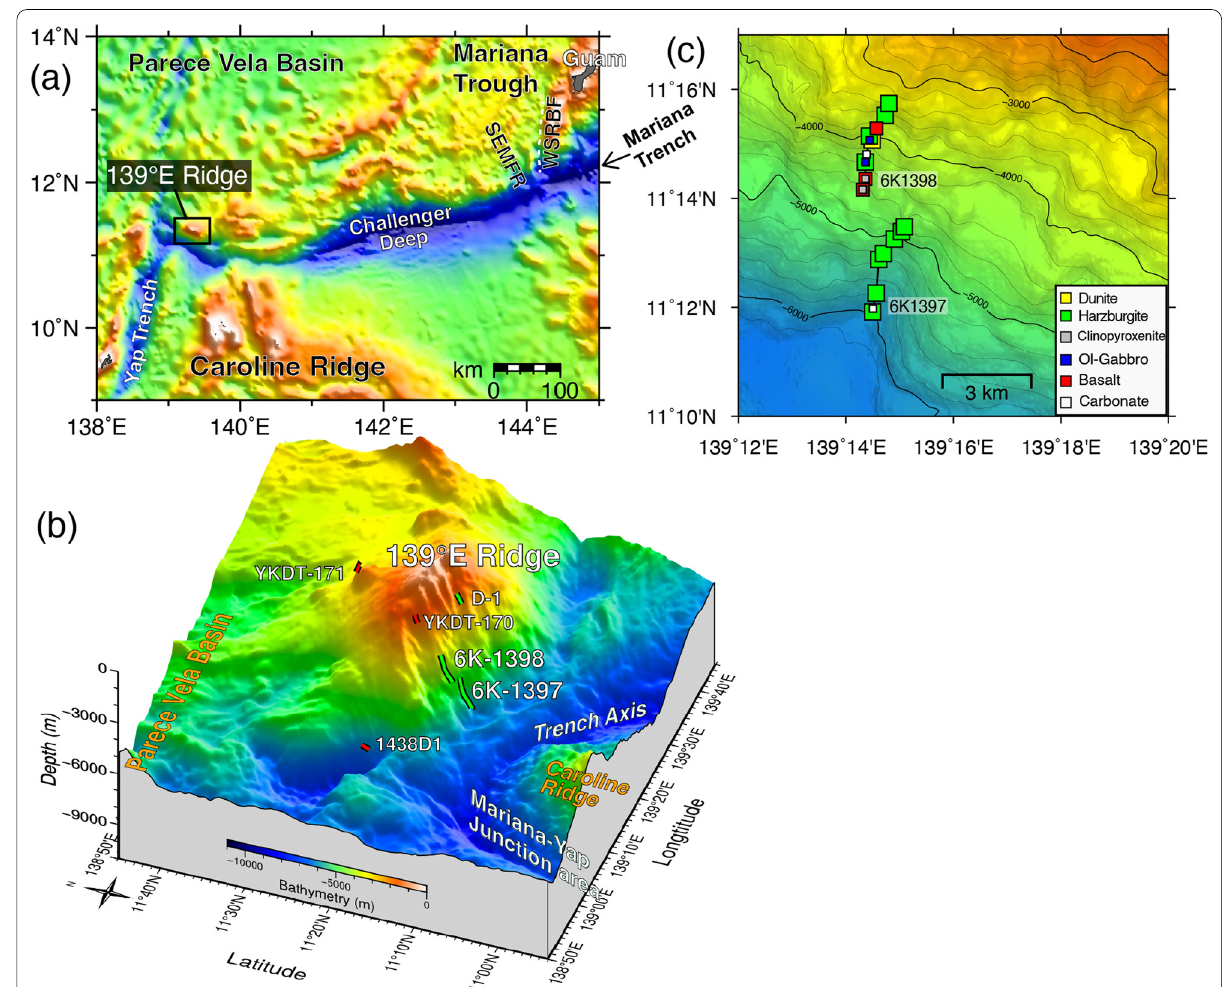
Fig. 1 a Bathymetric map of the region around the southern Mariana Trench. SEMFR: Southeast Mariana Forearc Ridge; WSRBF: West Santa Rosa Bank Fault. b Three‑dimensional perspective view of the 139°E Ridge. Shinkai 6500 dive tracks (6K‑1397 and 6K‑1398) are shown by green lines. Deep‑tow camera dive tracks (YKDT‑170 and YKDT‑171) are shown by red lines. D‑1 is the dredge line reported by Hawkins and Batiza (1977). 1438D1 is the dredge line reported by Beccaluva et al. (1980). c Lithologies recovered along the dive tracks plotted on a bathymetric map. The bathymetric dataset used in each panel is a compilation from the following bathymetric data: ETOPO1, U.S. Extended Continental Shelf Cruise (Armstrong 2010), and Yokosuka ship‑board